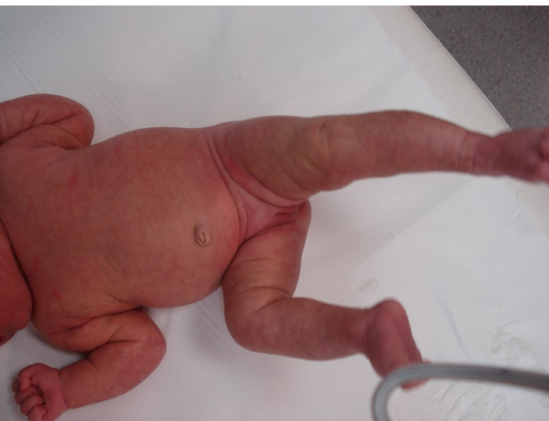
Figure 5. Generalized morbilliform rash and livedo racemosa both present at birth (the patient was diagnosed with pediatric multisystem inflammatory